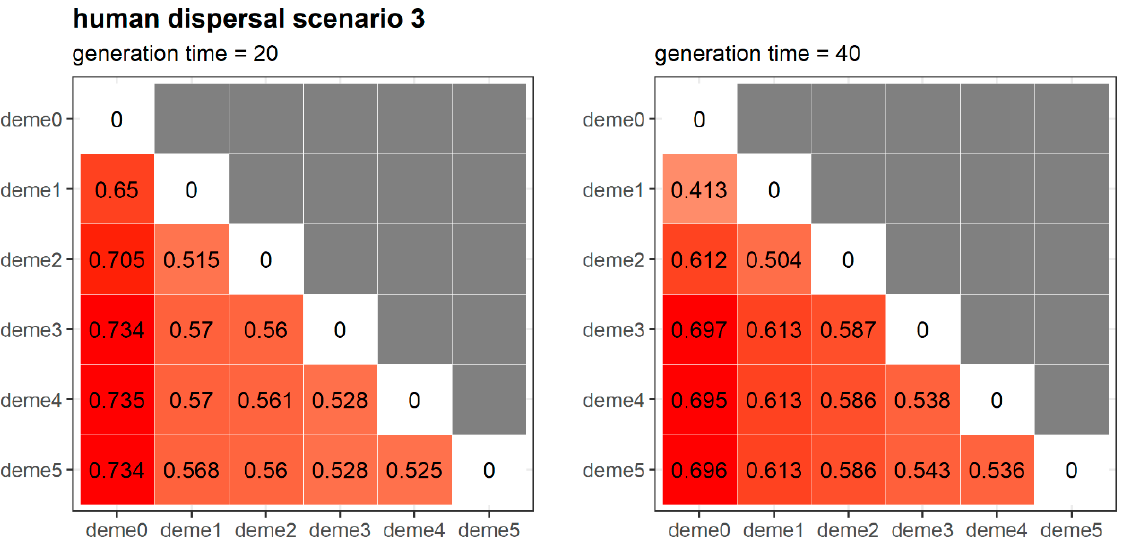
Figure A6. The mean pairwise Fst values calculated across 100 replicate simulations of a post- megafauna Indigenous-mediated dispersal scenario (“hd3” in Table A1). This scenario of Indigenous dispersal assumes that deme0 was established by propagules from deme1 5kya, followed by a symmetric island model of migration between all demes between 5000–4000 years ago.